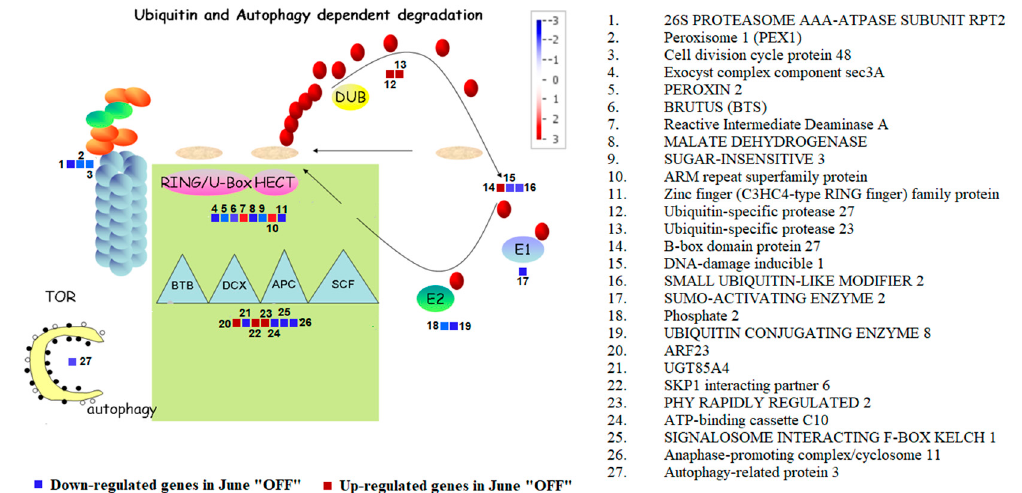
Figure 4. Figure shows Ubiquitin and Autophagy dependent degradation in Pistachio among the June “OFF” vs. June “ON” inflorescence bud comparison. The color scale indicates the log2 FC value. Red squares represent up-regulation and blue squares represent down-regulation in June “OFF” relative to June “ON”.